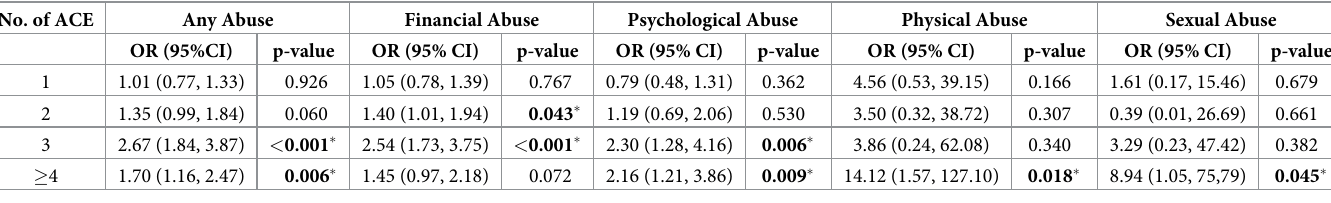
Table 3. Relationship between cumulative adverse childhood experiences and elder abuse subtypes.